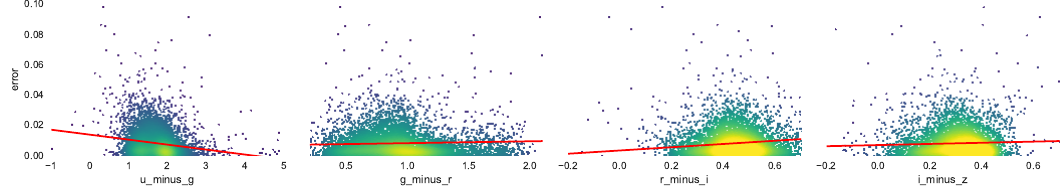
Figure 7. Normalized error when using the Random Forest classifier and different color